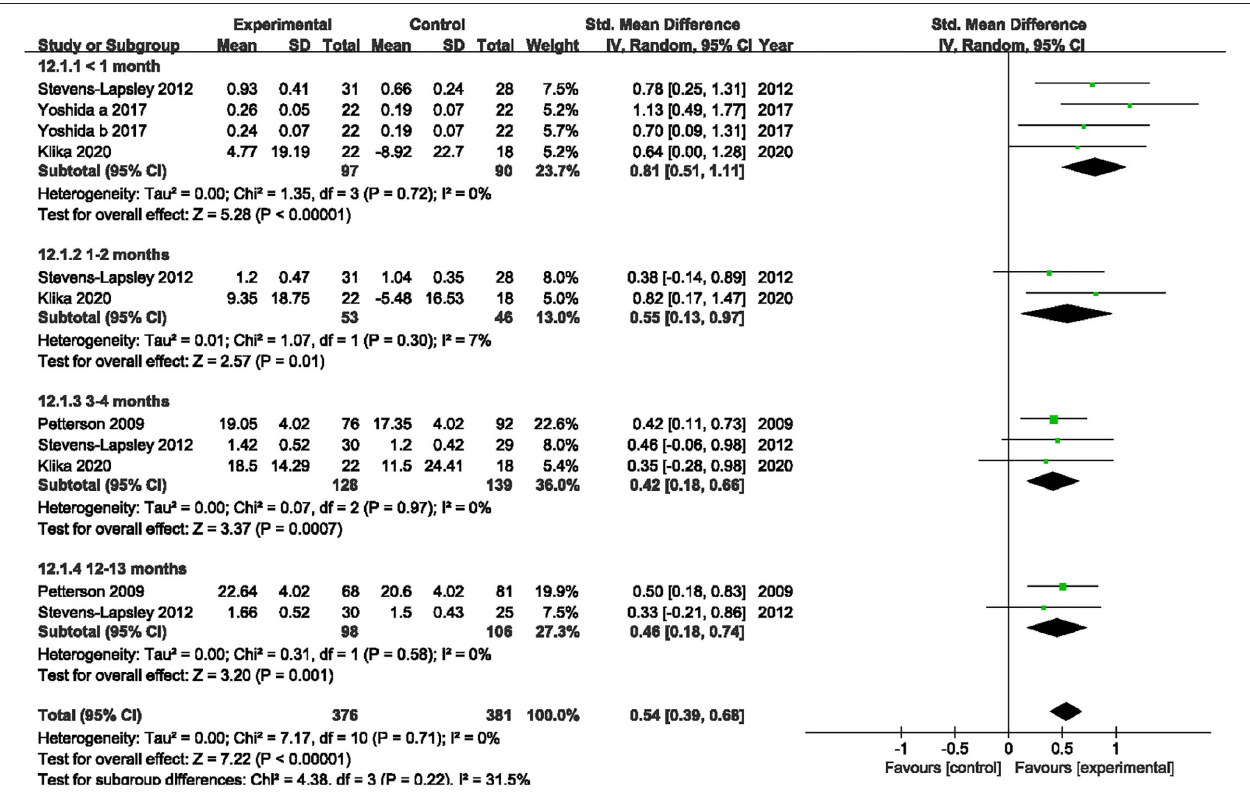
FIGURE 4 | Forest plots of meta-analysis of the effect of neuromuscular electrical stimulation (NMES) vs. conventional rehabilitation on quadriceps muscle strength.